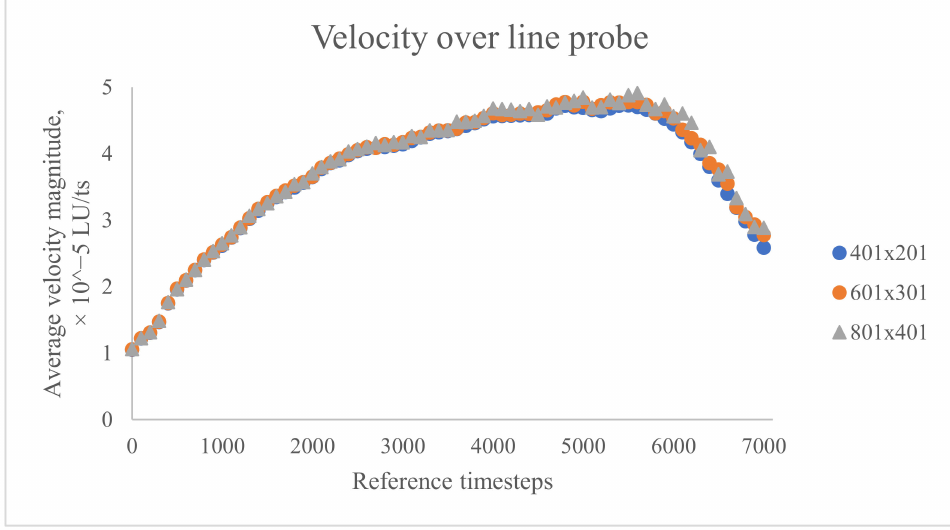
Figure 12. Average velocity magnitude along the probe line (shown in Figure 11) in the CO 2 penetration LBM